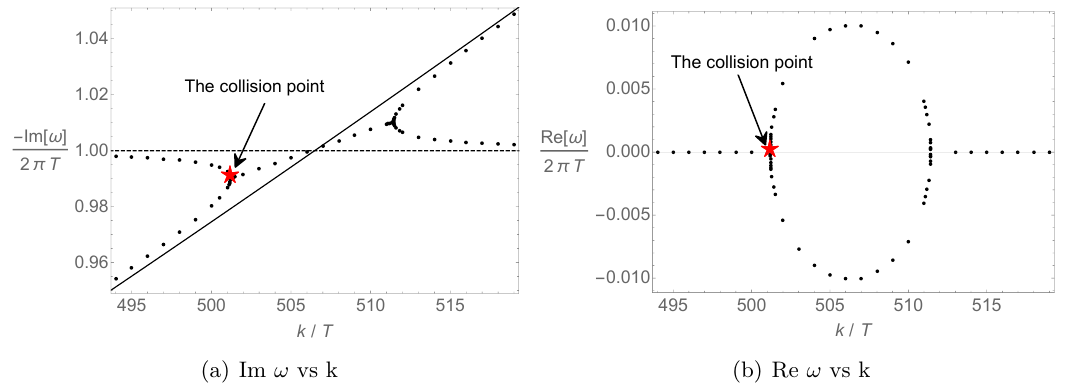
Figure 2 . The collision between the hydrodynamic mode and the first non-hydrodynamic mode. The left figure is the zoom of the gray region in figure 1. The red star corresponds to the collision point ( ω c , k c